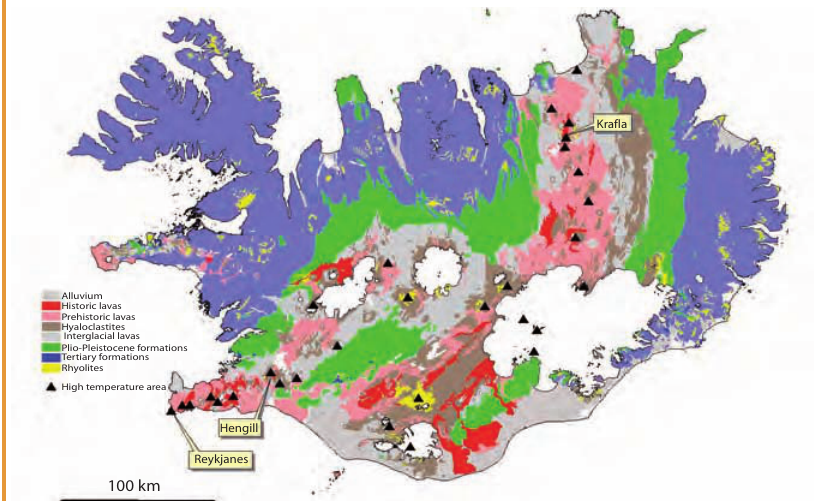
Figure 1. A geological map of Iceland showing the location of the three high-temperature hydrothermal systems being considered as sites for deep boreholes by the IDDP. (Map compiled by Haukur Johannesson and Kristján Saemundsson,